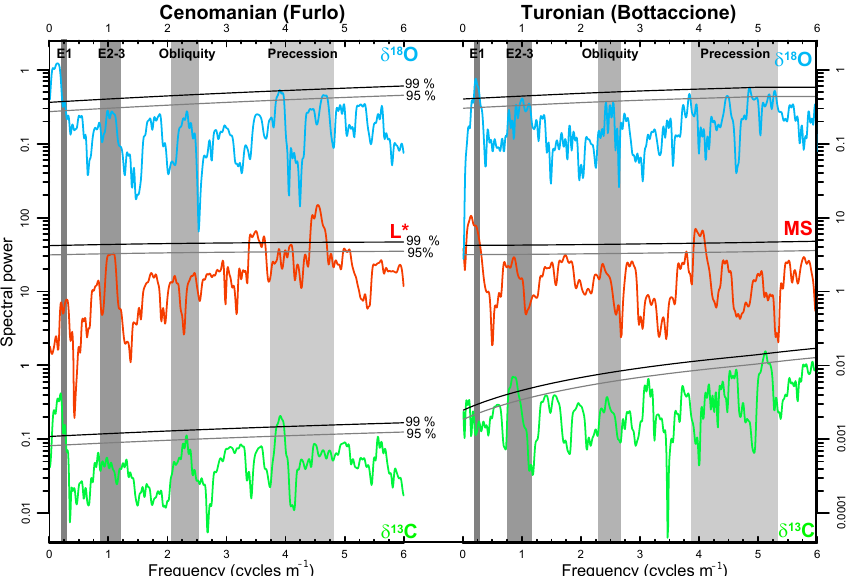
Figure 7. MTM/LOWSPEC spectra of proxy records. All proxy records show a strong imprint of eccentricity-modulated precession (E2–3: short eccentricity); δ 13 C from Furlo also displays a statistically significant (>95% confidence level) imprint of obliquity.